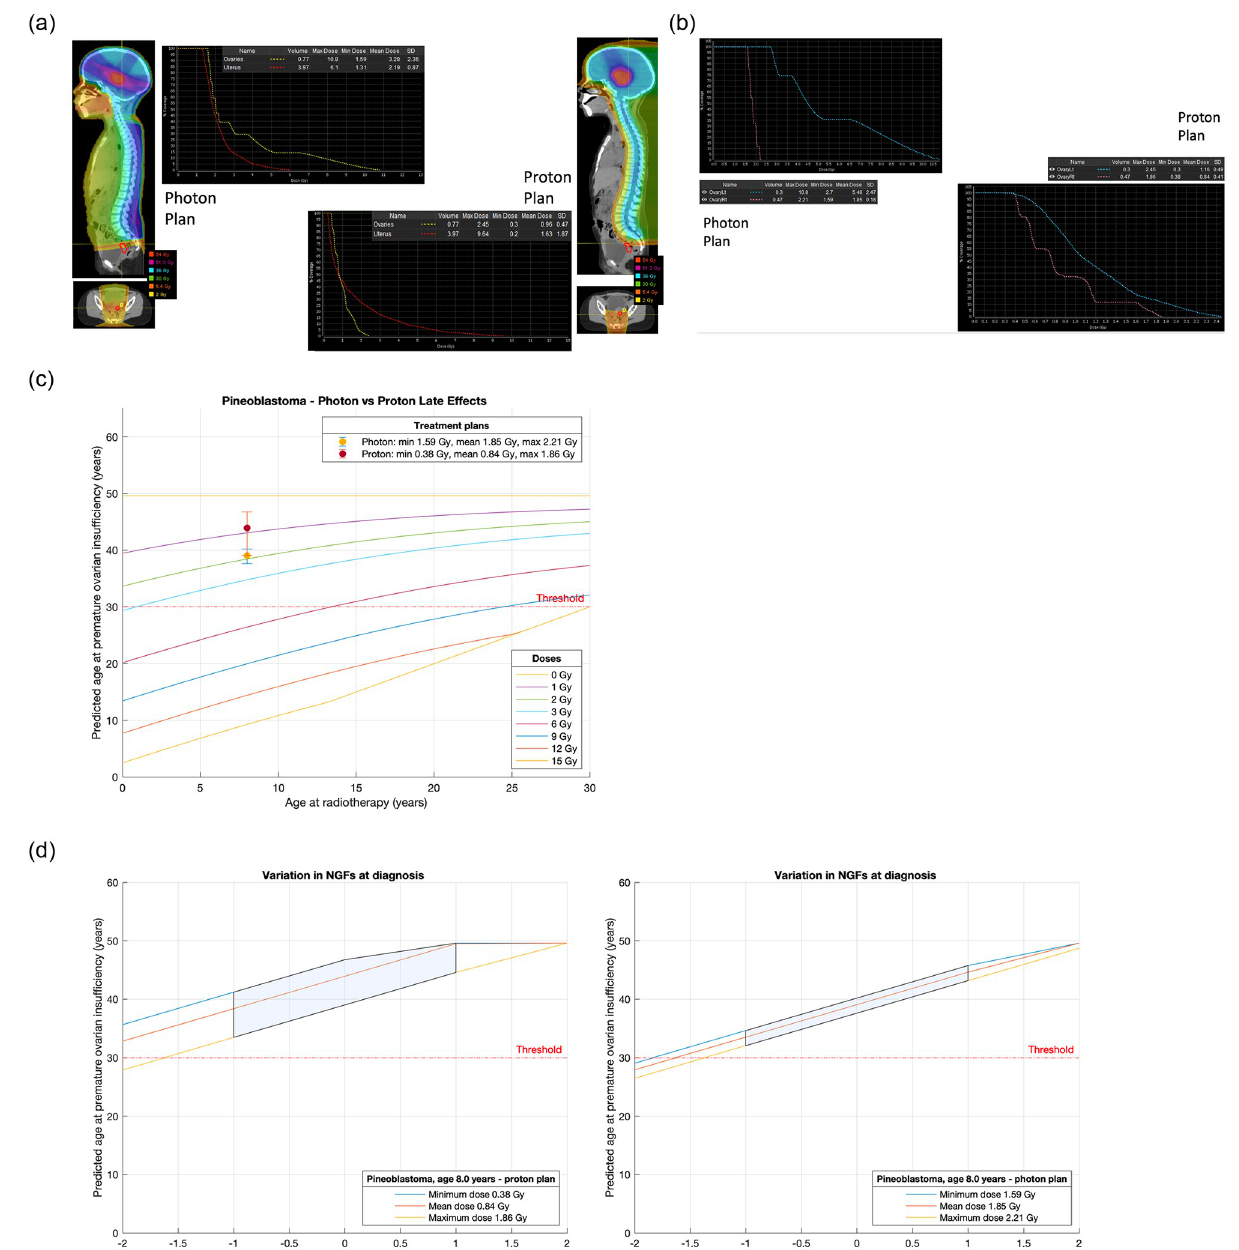
Fig 4. a . Treatment plans for Case 1, an 8-year-old with pineoblastoma. b . Analysis and comparison of dose received by each ovary for Case 1, an 8-year-old with pineoblastoma. c . Comparison of treatment plans assuming average NGF population at age of treatment (i.e., z-score = 0) for Case 1, an 8-year-old with pineoblastoma. Dots are predicted age at menopause after mean dose. Fertility window ranges between predicted ages for minimum & maximum dose. LD 50 is estimated to be 2 Gy. Dose is to the least affected ovary. d . Comparison of treatment plans for Case 1, an 8-year-old with pineoblastoma that incorporate uncertainty due to variation in NGF population at birth. (Or, equivalently, variation in ages at menopause). The